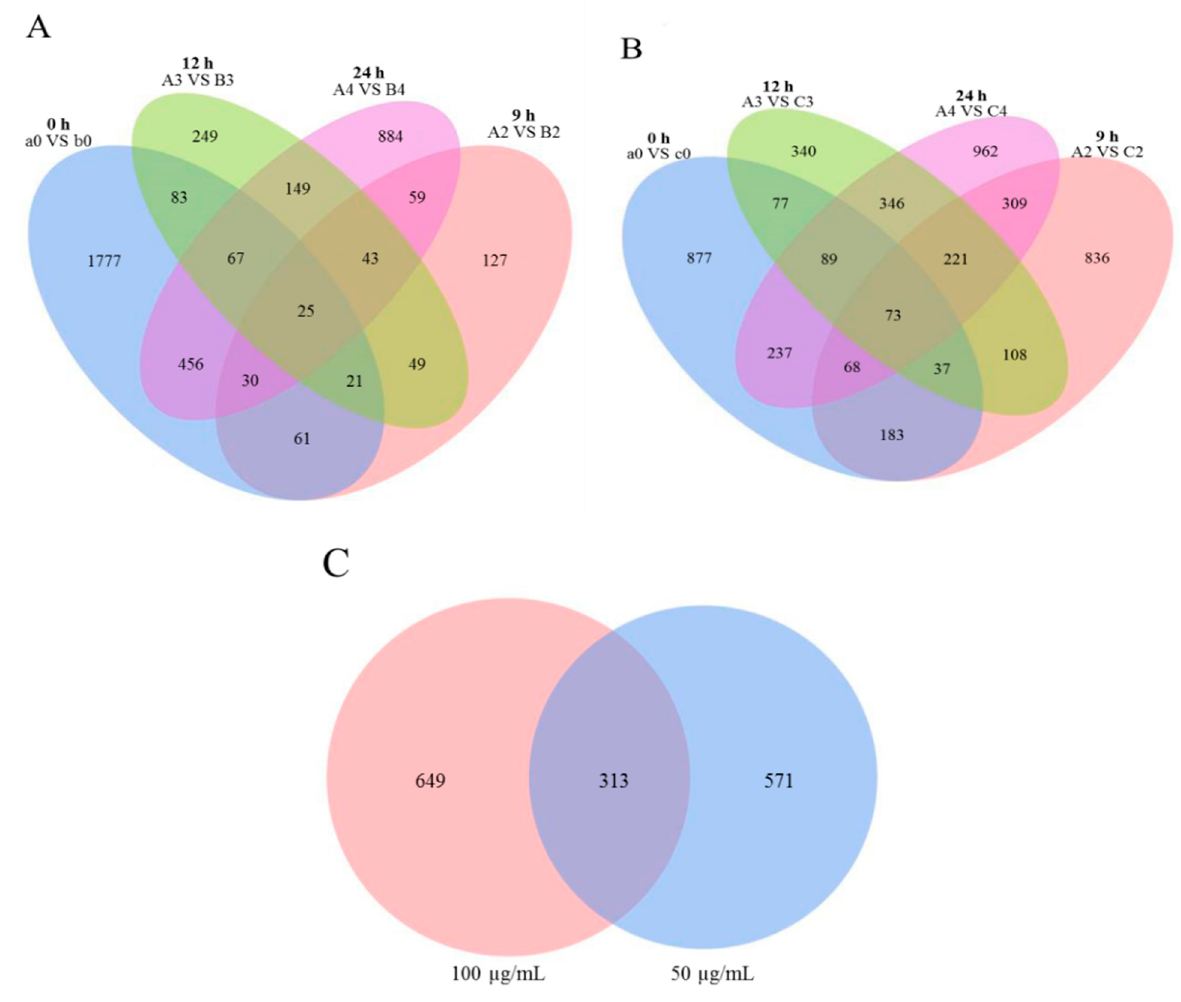
Figure 1. Venn diagram of DEGs in the evaluated libraries. ( A ) Venn map of all DEGs in M. oryzae after treatment with citral (50 μ g/mL) for the indicated times (h). ( B ) Venn map of all DEGs in M. oryzae after treatment with citral (100 μ g/mL) for the indicated times (h). ( C ) Venn map of specific DEGs in M. oryzae after treatment with citral for 24 h.